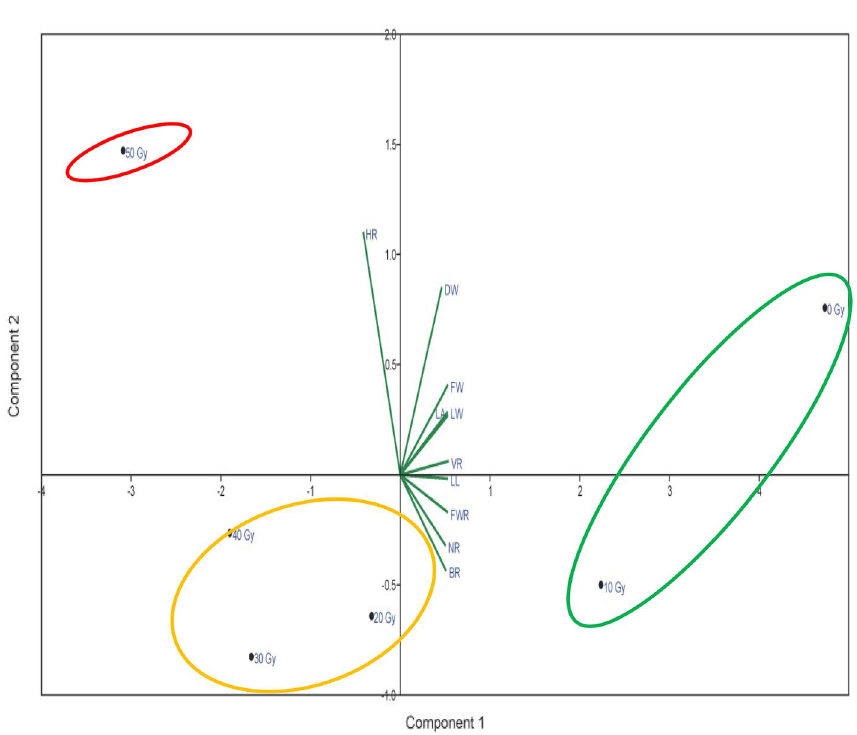
Figure 7. Principal component analysis (PCA) of the studied traits in different gamma treatments. Highest root (HR); Dry weight (DW); Biomass of root (BR); Number of root (NM); fresh weight of root (FWR); Leaf length (LL); Volume of root (VR); Fresh weight (FW); Leaf area (LA) and Leaf width